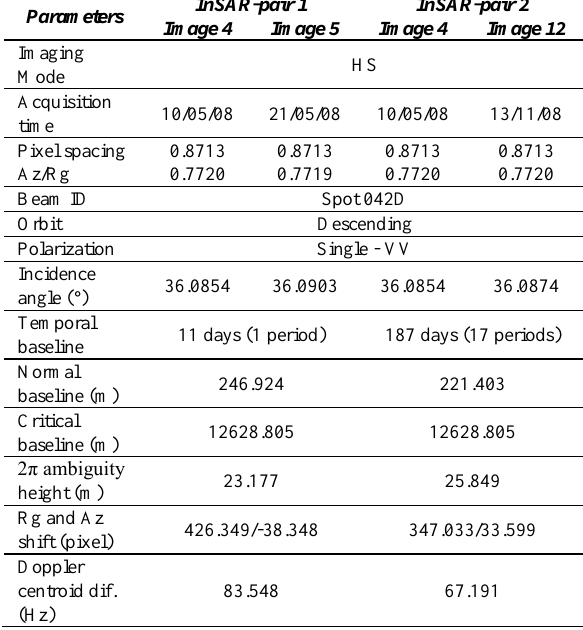
Table 1. Specifications and estimated baseline parameters